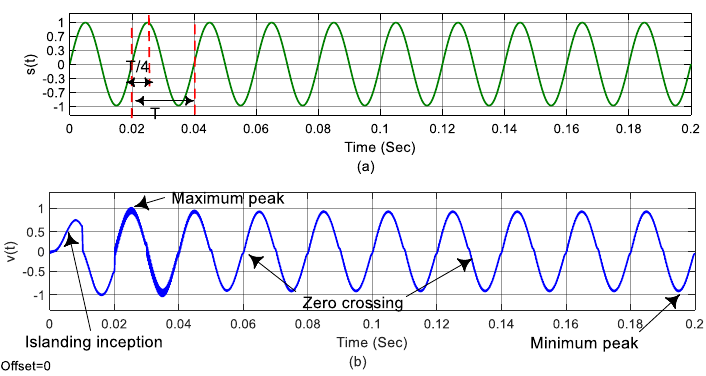
Figure 6. Feature extraction process: ( a ) Reference waveform 𝑠(𝑡) , ( b ) measured voltage at grid interconnection terminals 𝑣(𝑡) .